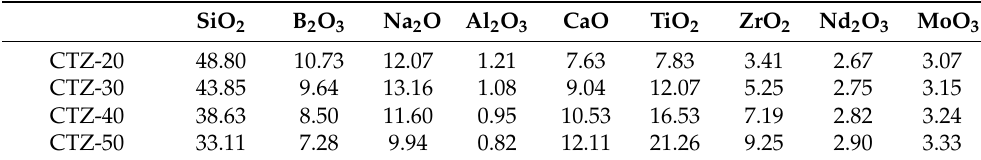
Table 1. Compositions of glass matrix